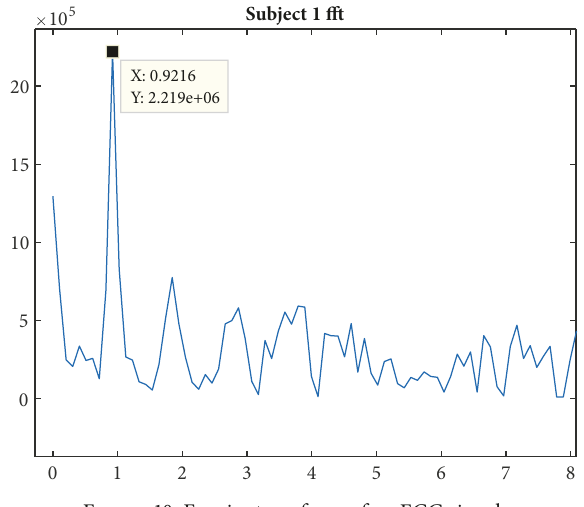
Figure 10: Fourier transform of an ECG signal.